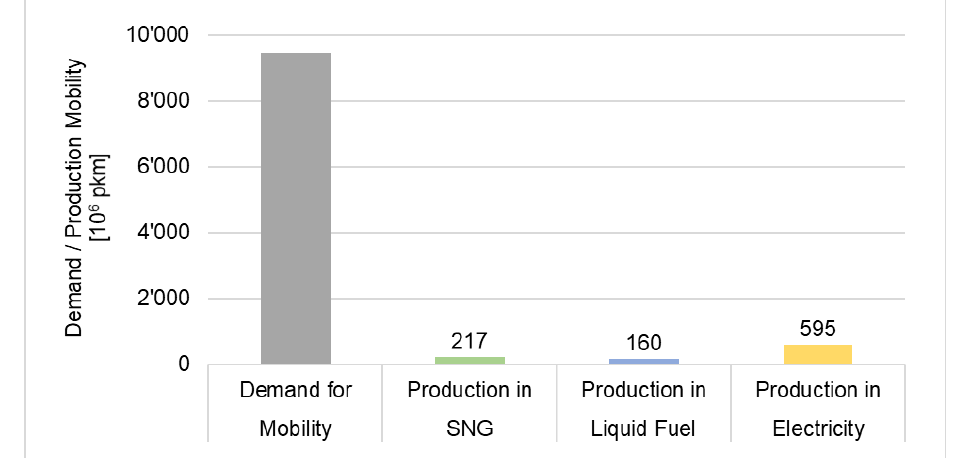
Figure 5. Energy demand and production for mobility differentiated by energy sources for the scenarios 2b (electric mobility), 3b (mobility with SNG), and 4b (mobility with liquid fuels), assuming that bioenergy is first used to cover electricity and heat demands and only thereafter to serve mobility purposes.